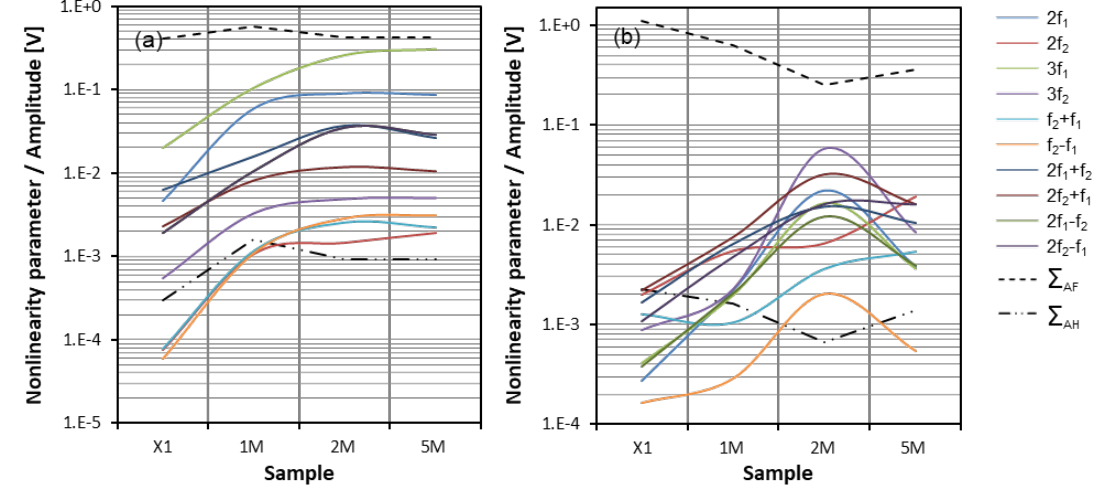
Figure 16. Nonlinearity parameter: ( a ) f 1 = 3 MHz, f 2 = 5 MHz, α = 90°; ( b ) f 1 = 4 MHz, f 2 = 5 MHz, α = 90°.